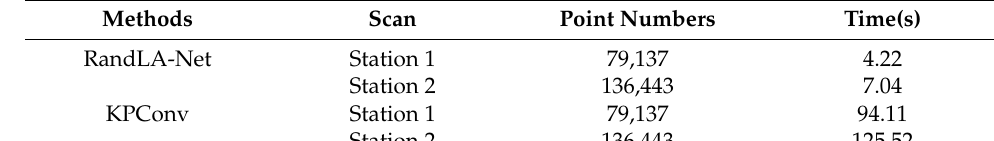
Table 3. Runtime of the two networks in the point cloud to be registered.